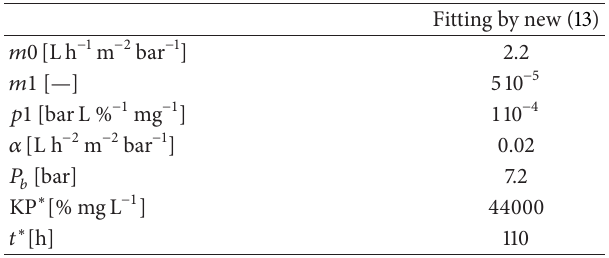
Table 2: Input data for (13) evaluation.